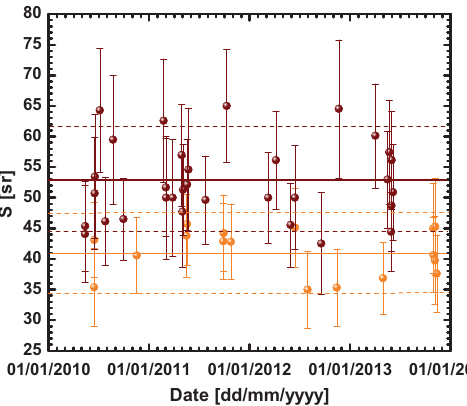
Figure 7. Dust-related lidar ratio S FT,d as shown in Fig. 5 (orange, Middle East dust) and Fig. 6 (brown, Saharan dust) with error bars (standard deviation) caused by realistic ± 10sr uncertainties in the lidar-ratio input parameters S PBL and S FT,s , and a 10% uncertainty in the separation of non-dust and dust backscatter coefficient. The solid and dashed (orange and brown) horizontal lines indicate the mean value of the 17 Middle East and 32 Saharan dust lidar ratios and the mean uncertainty (mean error bar length),